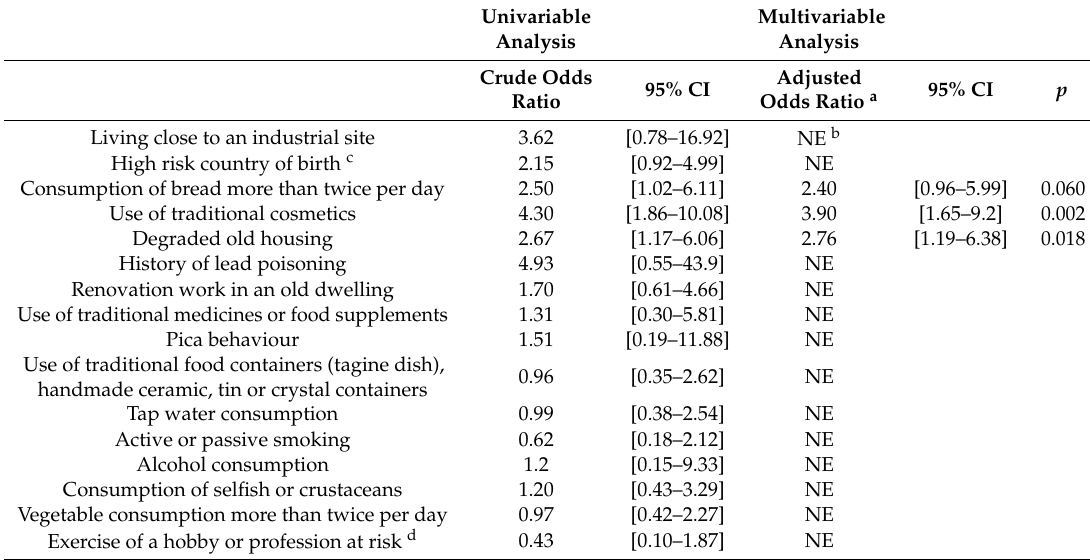
Table 3. Multivariate analysis of factors significantly associated with lead